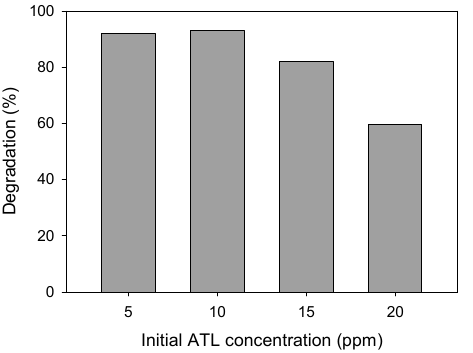
Figure 11. ATL degradation (%) using different concentrations of contaminant. AgCl nanoparticles concentration: 10 ppm.